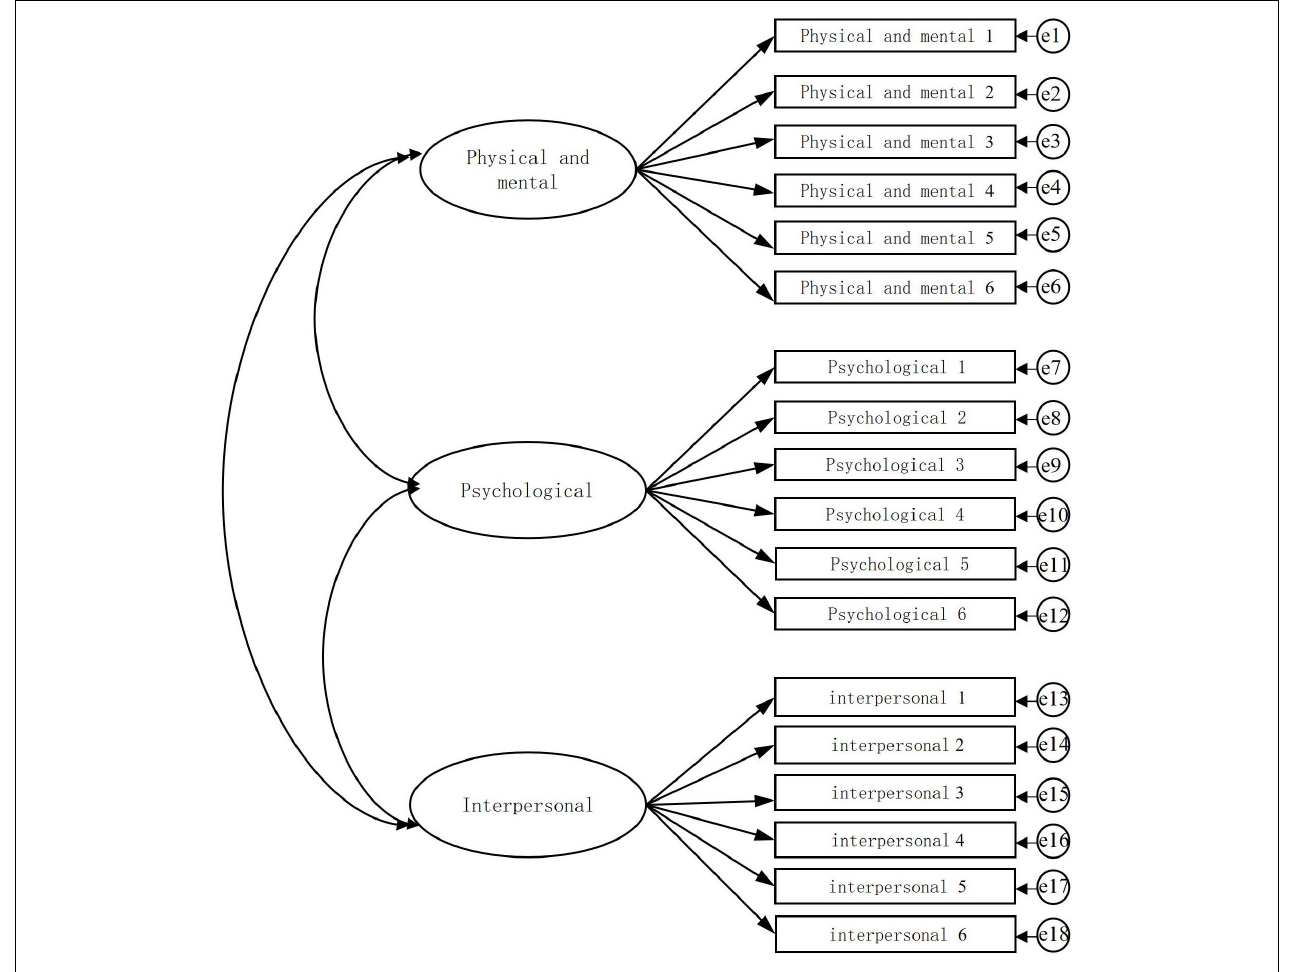
FIGURE 3 | Confirmatory factor analysis of mental vulnerability.